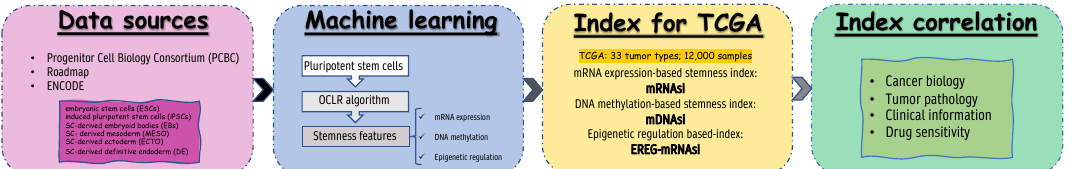
Figure 1. The overall methodology of the Stemness Indexes development [22]. The data sources from the Progenitor Cell Biology Consortium (https://www.synapse.org/pcbc), Roadmap (http://www.